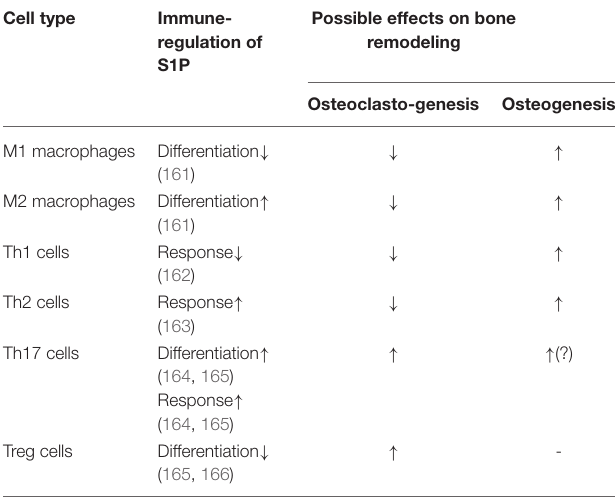
TABLE 2 | Possible effects of S1P-derived immune-regulation on bone remodeling. Cell